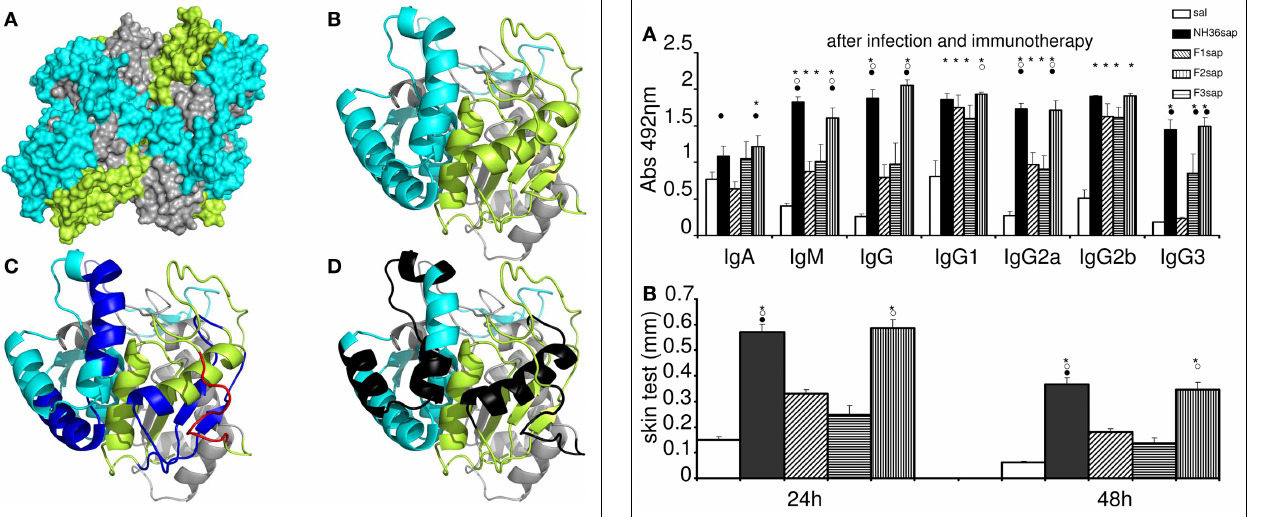
FIGURE 2 |Therapeutic vaccination, anti-NH36 antibodies, and intradermal response to L. amazonenis . Six weeks after infection with 10 5 metacyclic promastigotes of L. amazonensis in the footpads, Balb/c mice were further vaccinated with three subcutaneous doses of NH36sap, F1sap, F2sap, or F3sap at weekly intervals. Bars represent the mean ± SE of the absorbance values of anti-NH36 antibodies from 1/100 diluted serum (A) and intradermal response to the promastigote lysate of L. amazonensis (24 and 48h after antigen injection) (B) of two independent experiments with n = 6–7 mice per treatment performed after complete vaccination. * p < 0.05 different from the saline control; ◦ p < 0.05 different from the F2sap vaccine; • from the F1sap